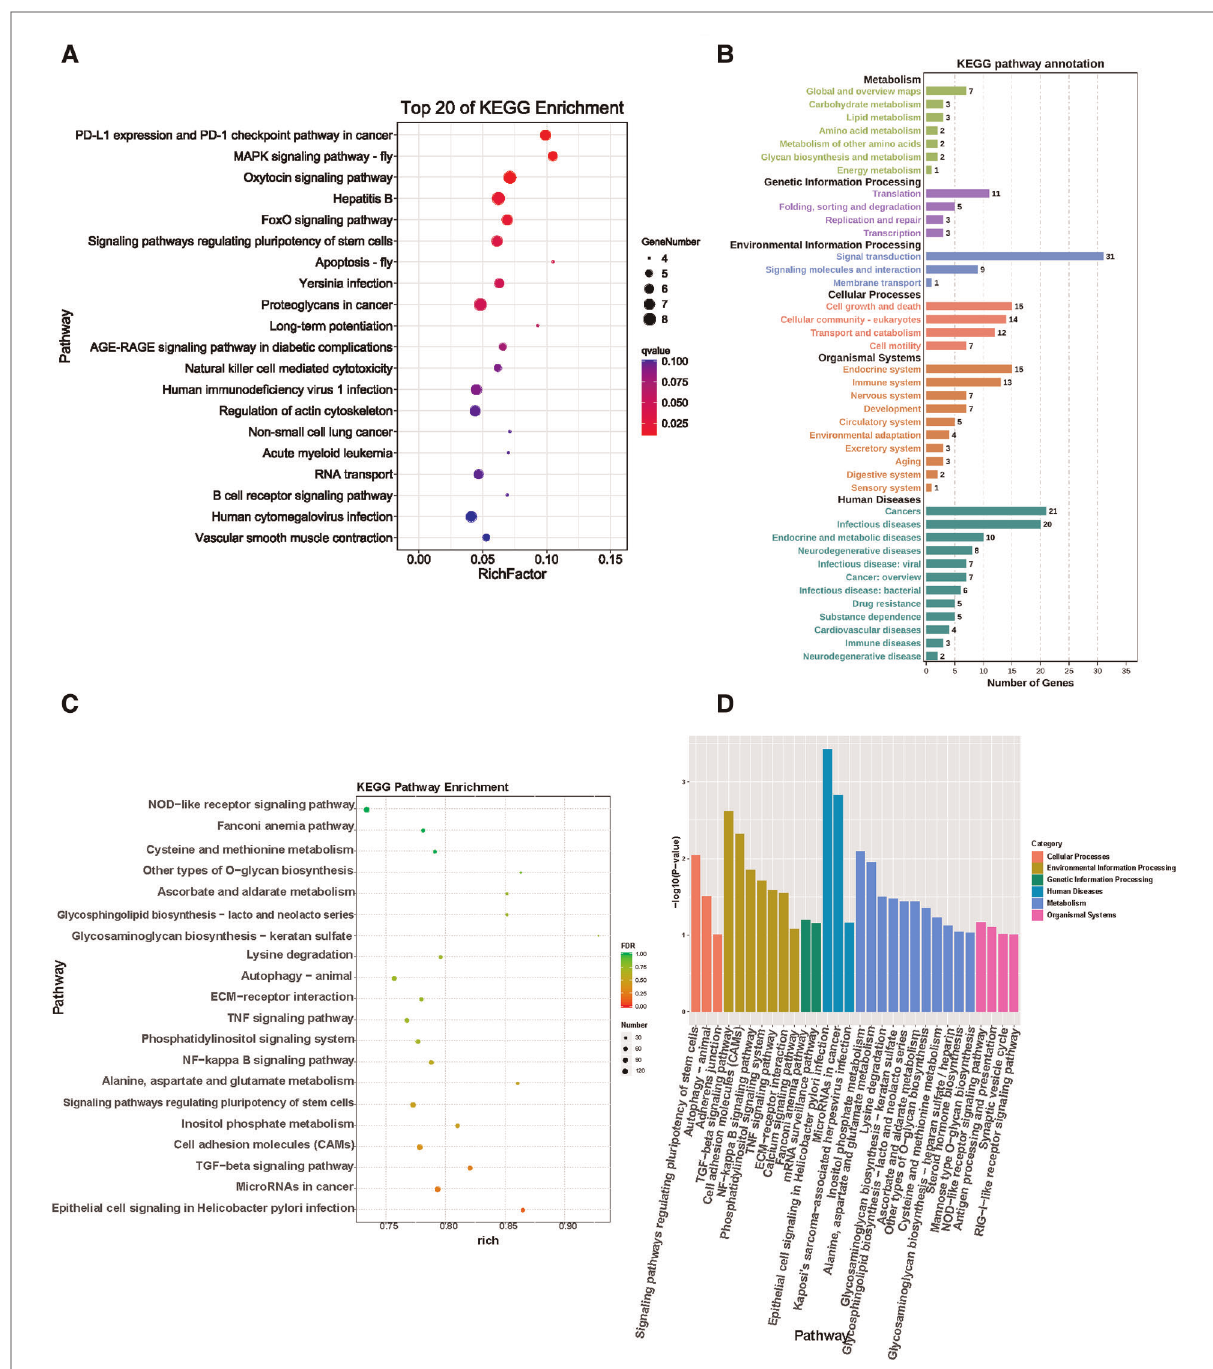
FIGURE 5 KEGG pathway enrichment analysis results of differential genes. ( A ) KEGG pathway enrichment results in differential expression of circRNAs in wound tissues of diabetic patients. ( B ). KEGG pathway enrichment analysis of differentially expressed circRNAs in diabetic wound tissues. ( C ) KEGG functional enrichment analysis of differentially expressed miRNAs in wound tissues of diabetic patients showed that the differentially expressed genes are involved in multiple signaling pathways. ( D ) KEGG pathway enrichment results of differentially expressed miRNA in diabetic wound tissues. According to the results of KEGG enrichment pathway analysis, the degree of enrichment was measured by rich factor, FDR values, and the number of miRNA target genes enriched on this pathway. The value range of FDR is 0 – 1. The closer it is to zero, the more signi fi cant the enrichment is. The top 20 KEGG pathways with the lowest FDR value and the most signi fi cant enrichment are selected for display. The abscissa is the name of the path, and the ordinate is — log10 ( p -value) of each